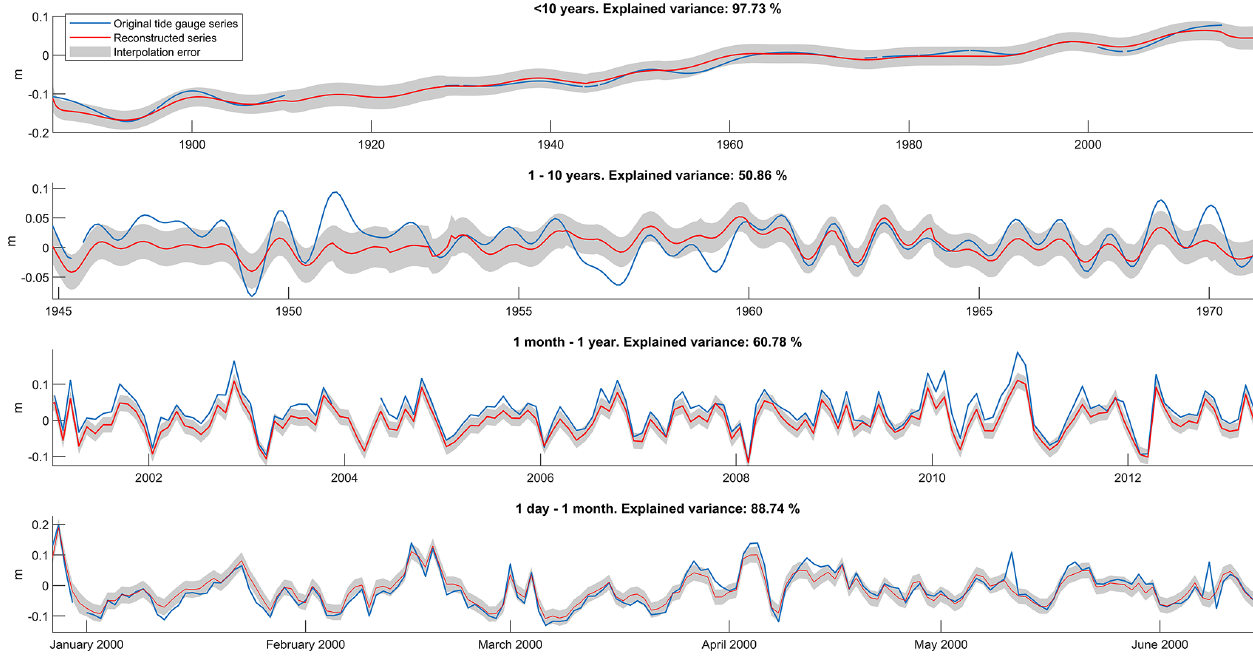
Figure 6. The same as Fig. 5 but for the Genoa tide